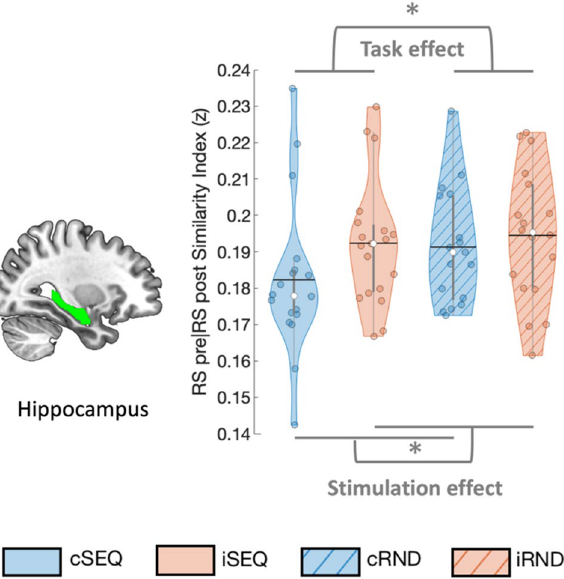
Figure 5. Similarity between RS pre- and post-intervention. Hippocampal pattern similarity between pre and post RS was influenced by task and stimulation condition such that lower similarity was observed after sequence learning as compared to random practice as well as after cTBS as compared to iTBS. Colored circles represent individual data, jittered in arbitrary distances on the x-axis within the respective violin plot to increase perceptibility. Black horizontal lines represent means and white circles represent medians. The shape of the violin plots depicts the distribution of the data and grey vertical lines represent quartiles. Asterisk (*) indicates significance at p < 0.05. RS - resting-state, SEQ - sequence learning task version, RND - random task version, c - continuous, i - intermittent.